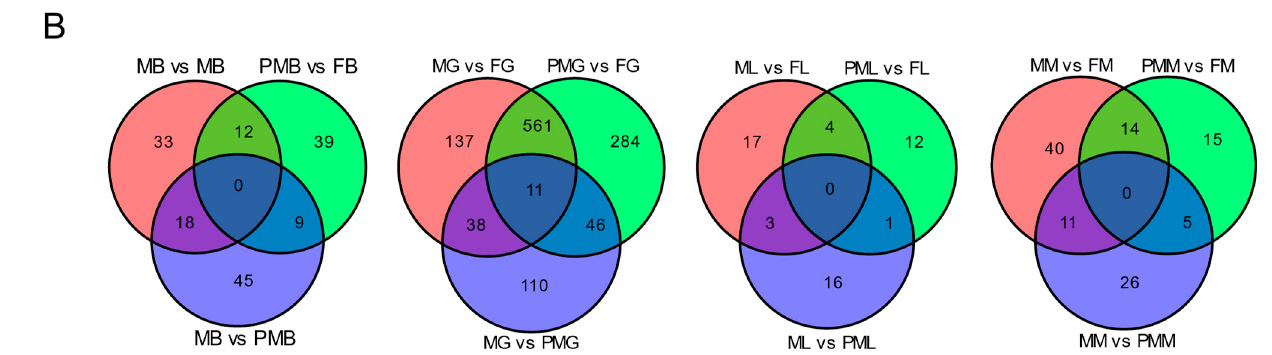
Figure 2. Identification and characterization for DE circRNAs in different sexual C. semilaevis . ( A ) Basic difference analysis histogram of DE circRNAs from the brain, gonad, liver, and muscle in female, male, and pseudo-male individuals. ( B ) Venn diagrams of DE circRNAs.